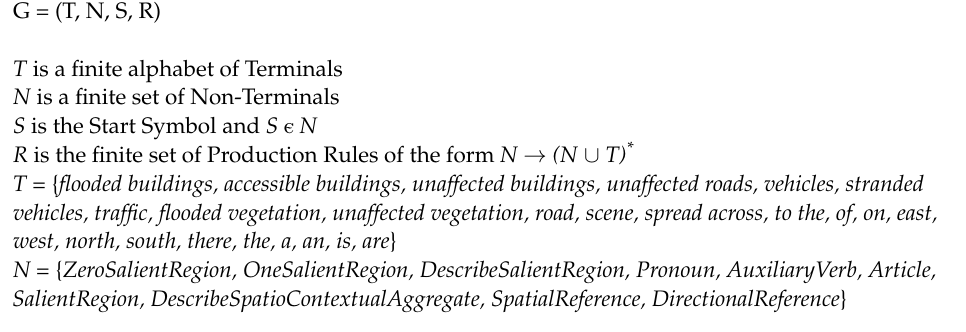
Algorithm 5 Remote Sensing Scene Description Grammar G